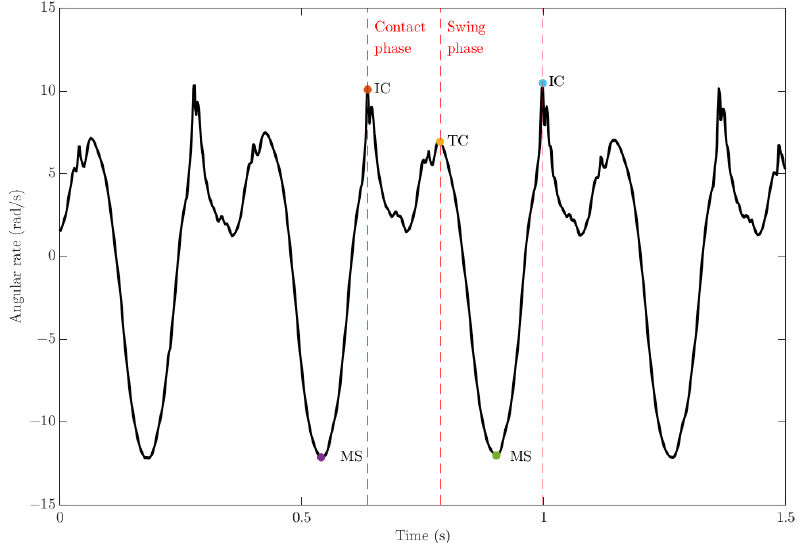
Figure 3. Random samples of right ankle angular rate ω ankleR of a participant during 75% maximum running speed. Please note that MS = Mid-Swing; IC = Initial-Contact; TC =